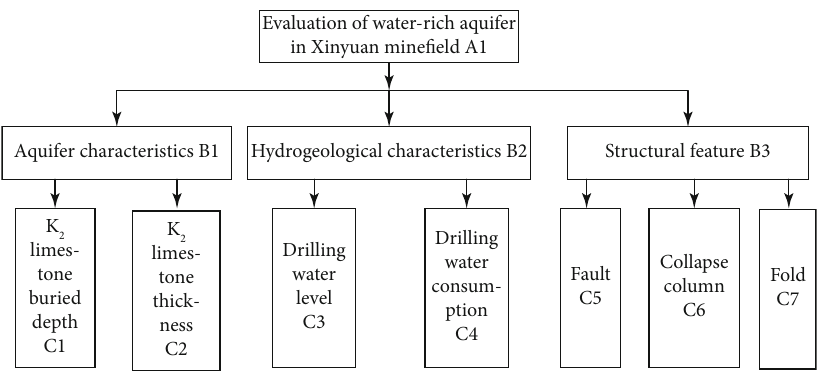
limestone aquifer. 2